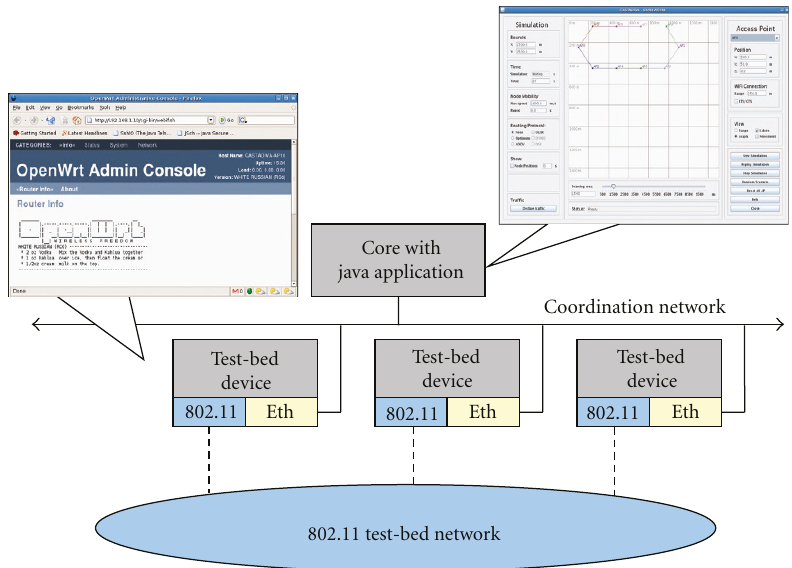
Figure 1: Schema of Castadiva ’s